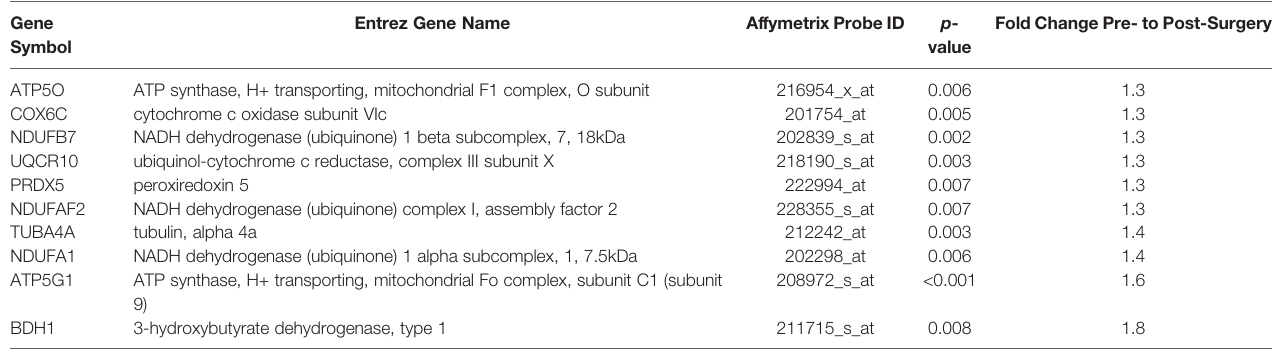
Fold change = post-surgery expression T2D/pre-surgery expression